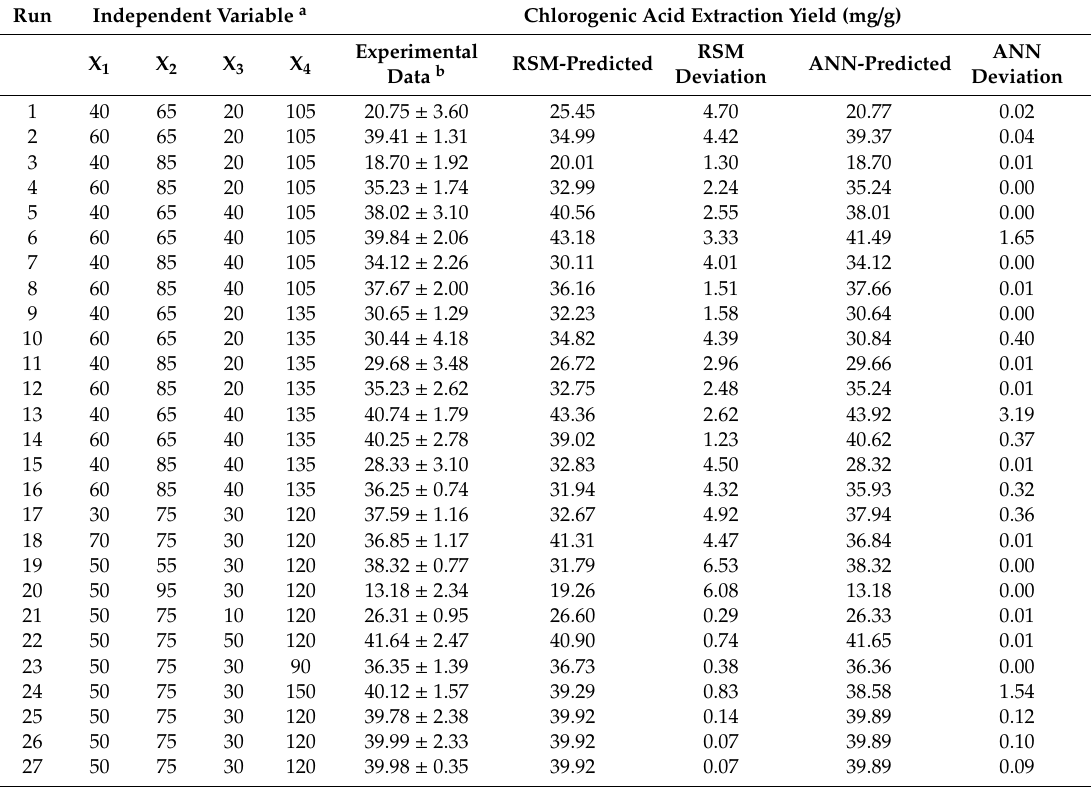
Table 2. Central composite rotatable design (CCRD) and experimental data for 5-level-4-factor response surface